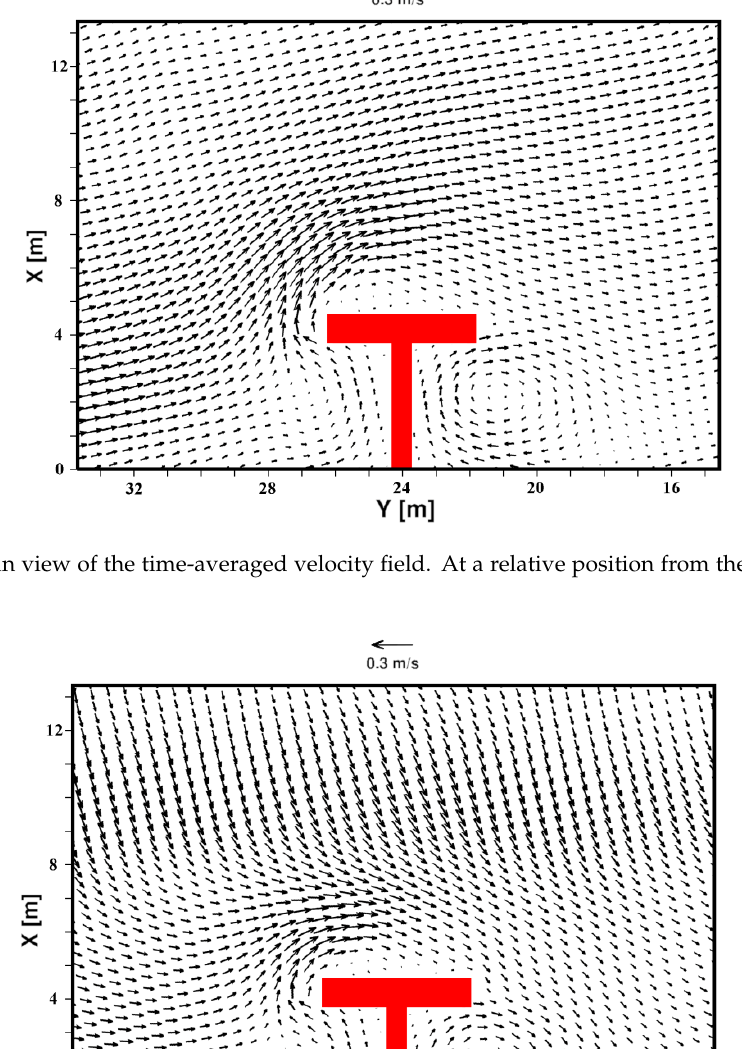
Figure 6. Plan view of the time-averaged velocity field. Near the bed, at a relative position from the free surface of 𝑧/𝑧 𝑏 = 0.933 .